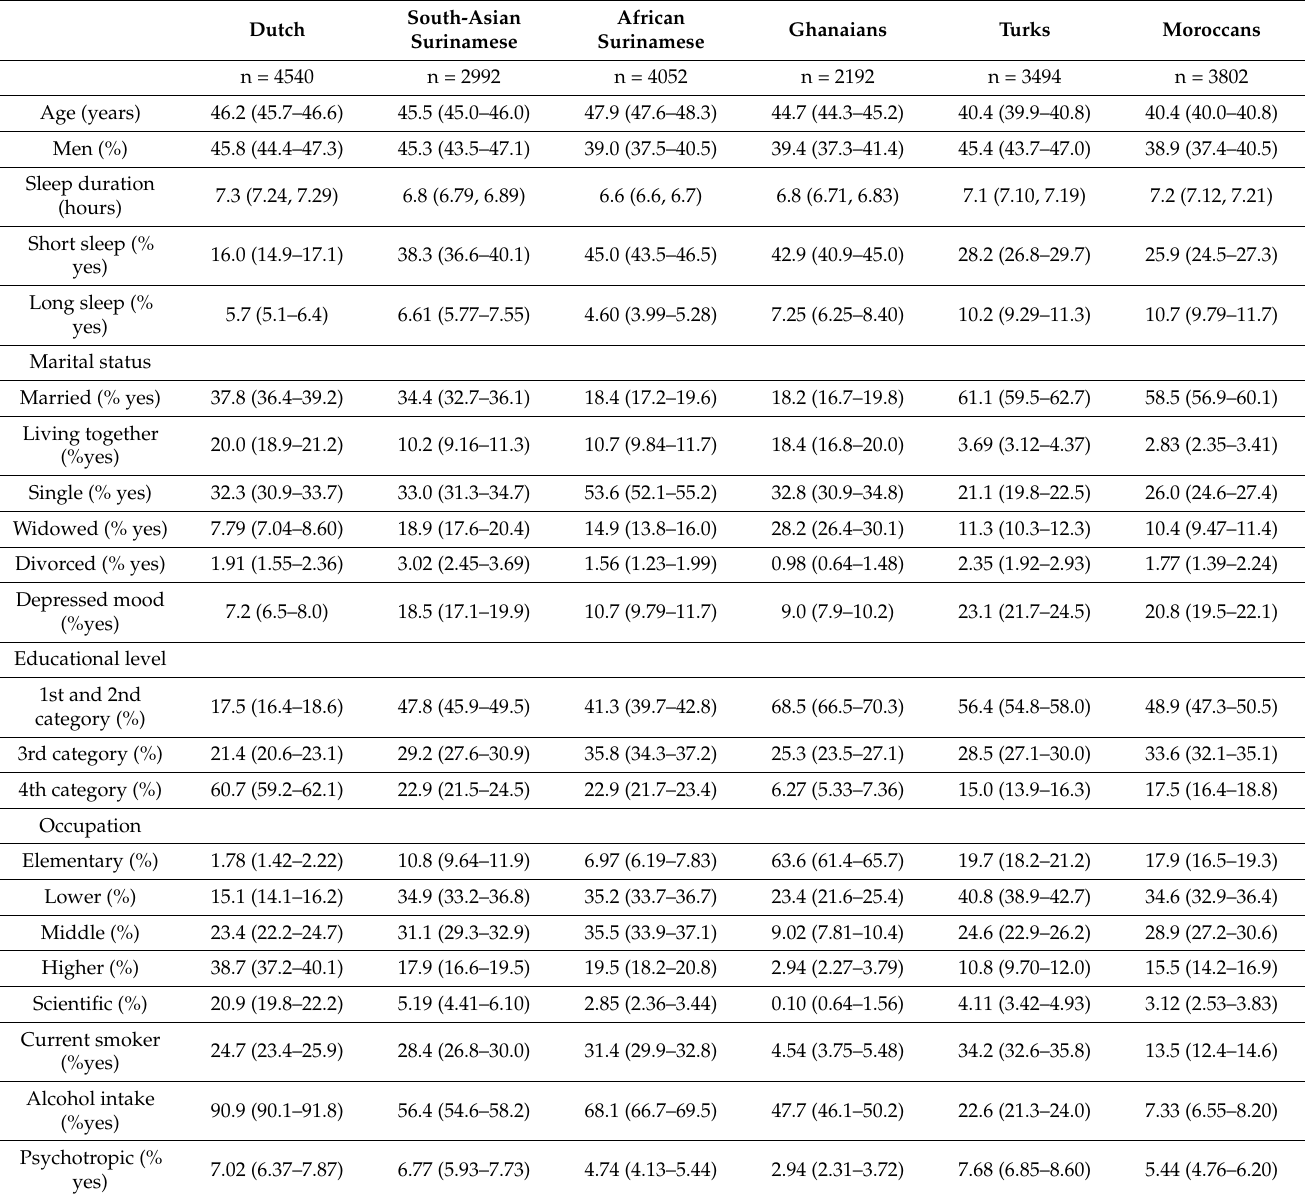
Table 1. Characteristics of the study